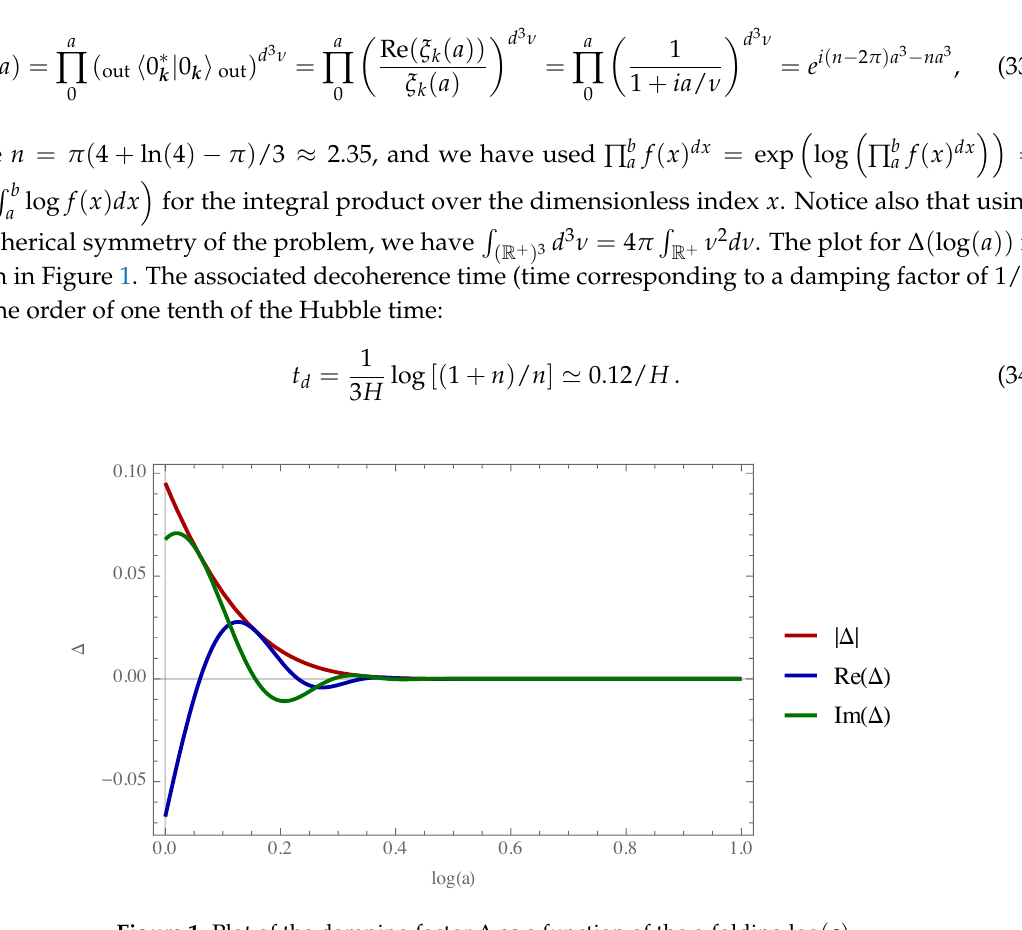
Figure 1. Plot of the damping factor ∆ as a function of the e-folding log ( a )